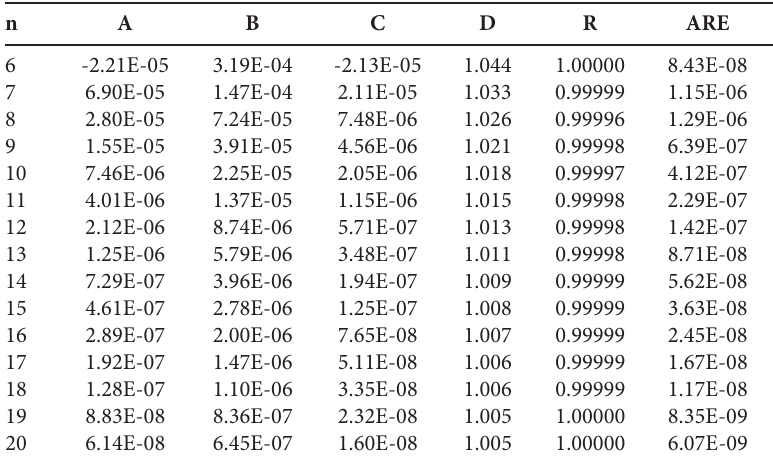
Table 1. Coefficients A, B, C, and D, in (4), computed to achieve the best correlation coeffi- cient for chemical trees from 6 to 20 vertices. Last two columns contain obtained correlation coefficients and the average relative errors for all data sets used.